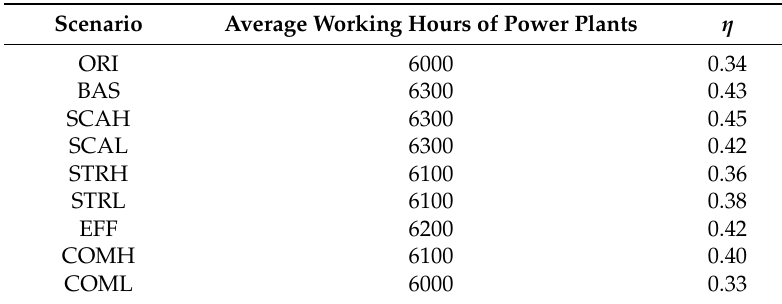
Table 9. Results of parameter